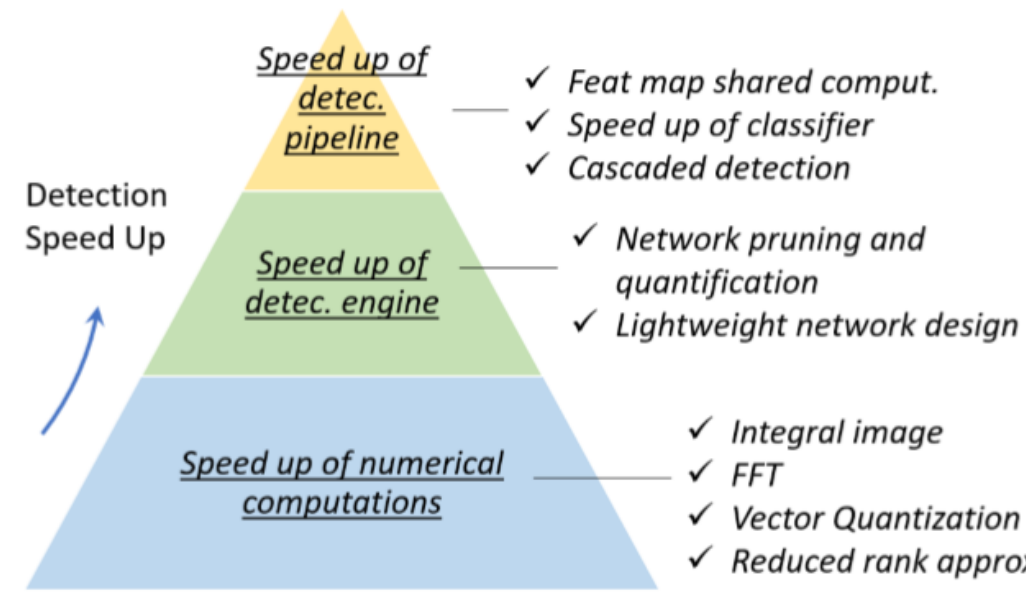
Figure 15. Overview of acceleration techniques (source: